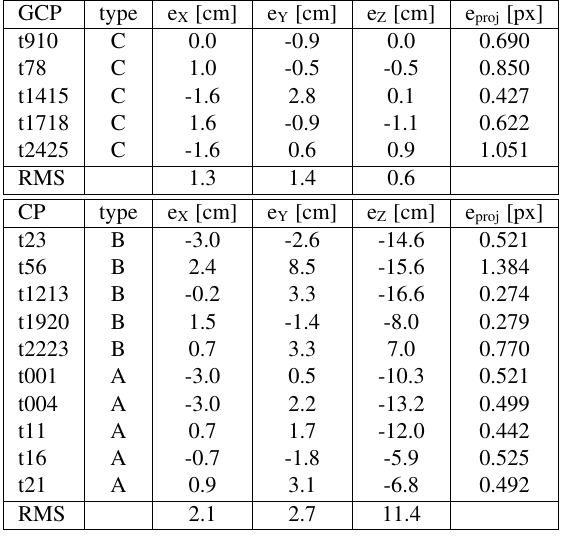
Table 3. Road cones as GCPs, errors on GCPs and CPs